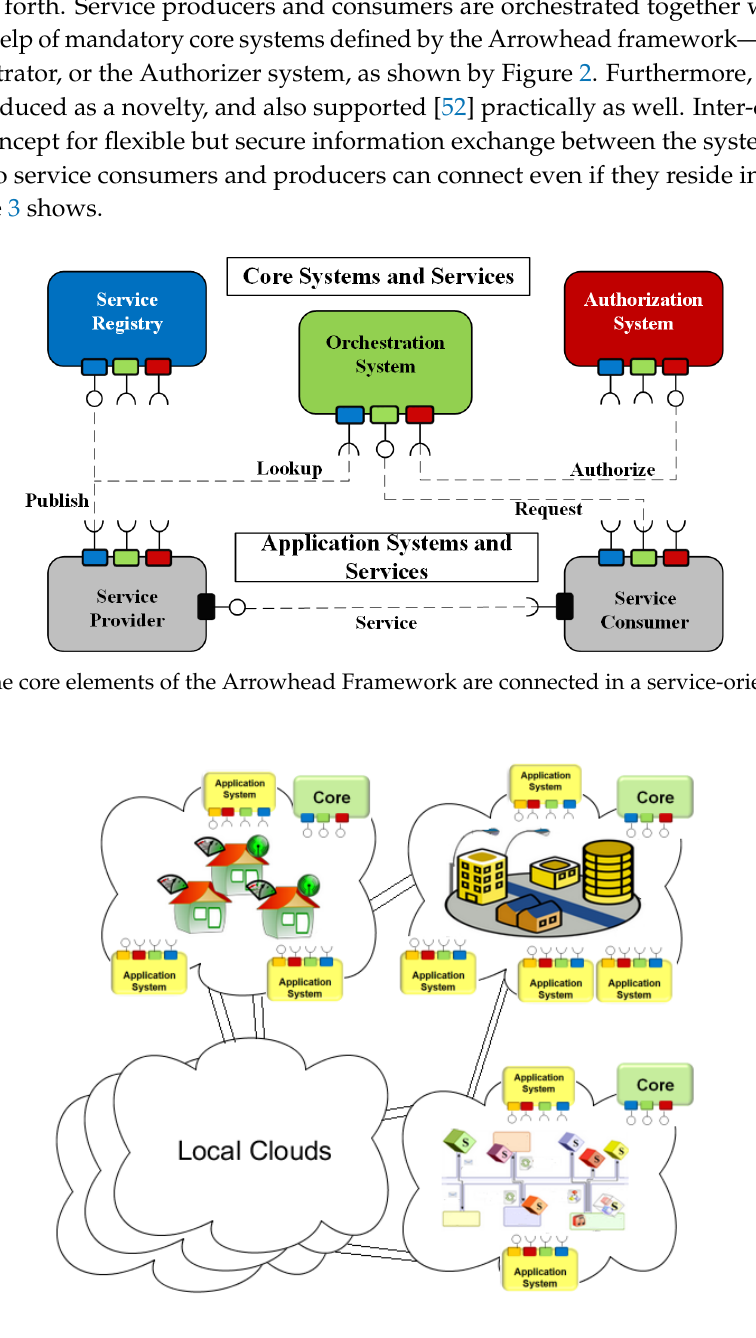
Figure 3. Local clouds with serving different industrial domains have their internal requirements (such as latency or security) guaranteed—and they can produce and consume services to/from other Local clouds as well.